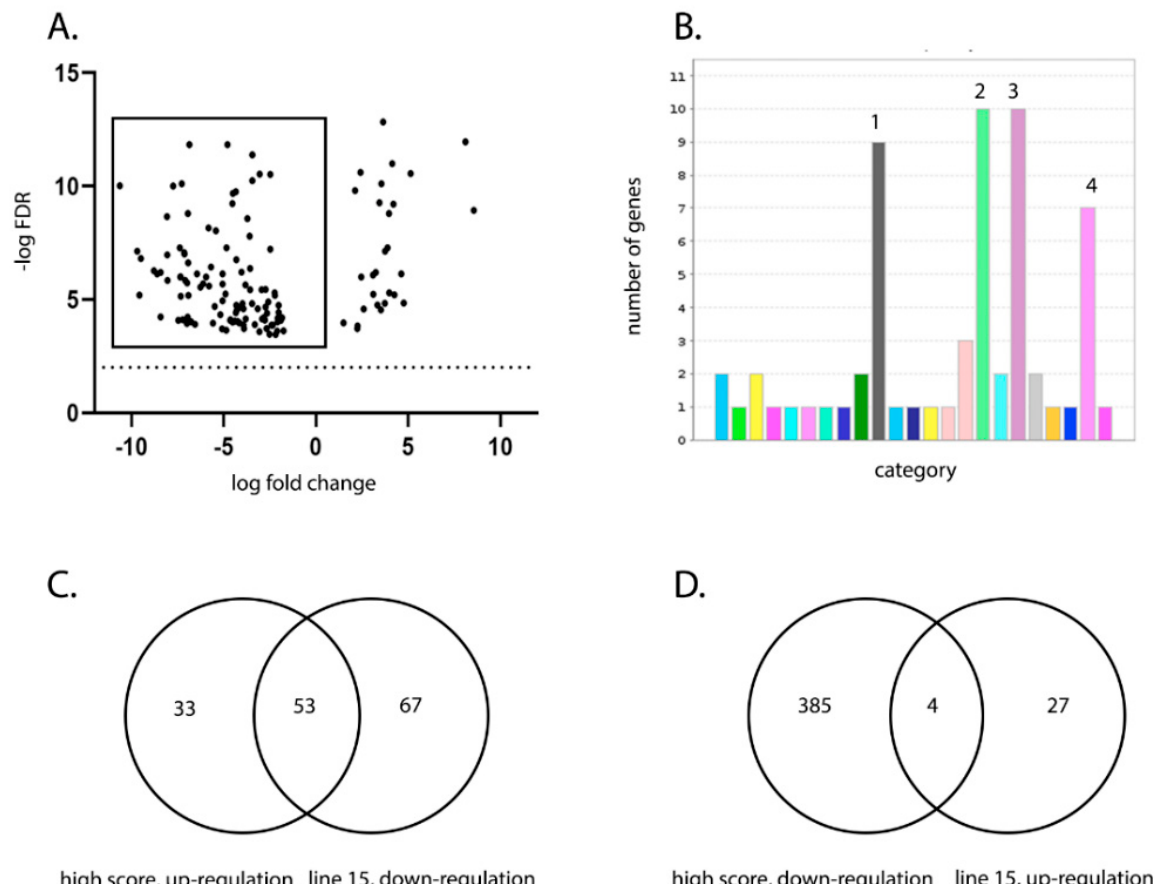
Figure 5. Line W birds showed up-regulation of pathways involved in inflammation mediated by chemokine and cytokine signaling, cytoskeletal regulation by Rho GTPases, nicotinic acetylcholine receptor signaling, and Wnt signaling in the BF compared to line 15 birds. Transcriptional profiles of infected birds at 3 dpi from line W and line 15 were compared, with line W as a baseline. RNA was extracted from the BF of the birds and subjected to RNA-seq. The expression of the target genes was reported as fold-change (FC), with values ≥ 2 considered as up-regulated, and values ≤− 2 considered as down-regulated. The FDR was calculated and a volcano plot of –log FDR over log2 FC plotted; FDR values of ≤ 0.05 were considered as significant. Each dot represents one gene, and genes that were down-regulated in line 15 birds compared to line W (i.e., up-regulated in line W compared to line 15) are boxed ( A ). Pathway analysis using PANTHER revealed that 4 pathways were significantly up-regulated: 1 (grey)- inflammation mediated by chemokine and cytokine signaling, 2 (green)- cytoskeletal regulation by Rho GTPases, 3 (purple)- nicotinic acetylcholine receptor signaling, and 4 (pink)- Wnt signaling ( B ). A Venn diagram was plotted of the genes that were up-regulated in birds that had a high clinical score compared to low clinical score and genes that were down-regulated in line 15 birds compared to line W (i.e., genes that were up-regulated in line W birds compared to line 15) ( C ). A Venn diagram was plotted of the genes that were down-regulated in birds that had a high clinical score compared to low clinical score and genes that were up-regulated in line 15 birds compared to line W (i.e., genes that were down-regulated in line W birds compared to line 15) ( D